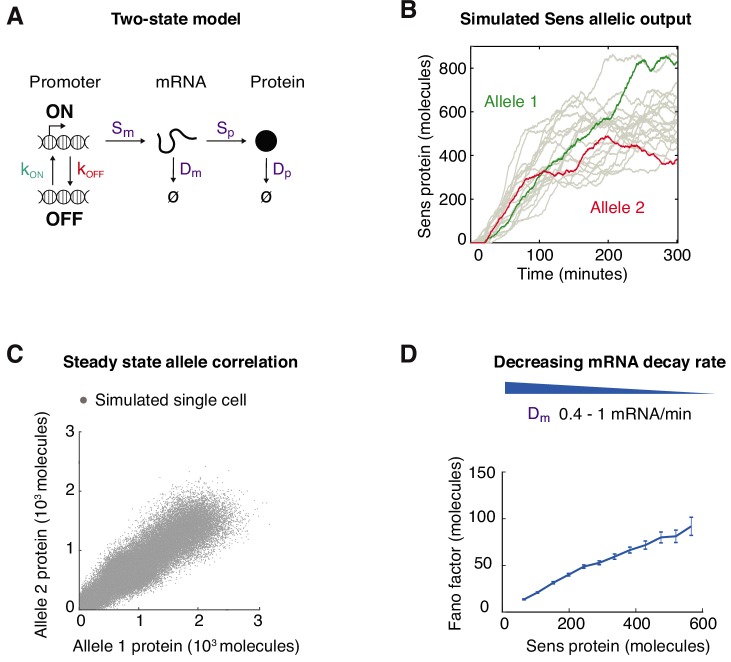
Modeling of Sens expression and noise.(A) Simple two-state model of gene expression with six rate parameters as shown. (B) Simulated trajectories of Sens protein molecule numbers over time starting from zero molecules. Two randomly paired trajectories are shown in green and red, which mimic two independently acting alleles within the same cell. (C) Sens protein output from randomly paired virtual alleles. Sampling was taken when all simulations had reached steady state. The kon rate parameter was varied to generate a range of steady-state protein output, and pairing was only done between simulations with identical rate parameters. The full range of Sens expression can be recapitulated by varying any of the six gene expression rate parameters in the model. (D) Simulations were performed by systematically varying the mRNA decay rate constant Dm and the Fano factor was calculated for bins of randomly paired simulations according to their protein output. Error bars are 95% confidence intervals as calculated by bootstrapping. The resulting Fano factor slowly rises as protein levels increase. Similar profiles were obtained if the rate parameters Sp and Dp were systematically varied (not shown).